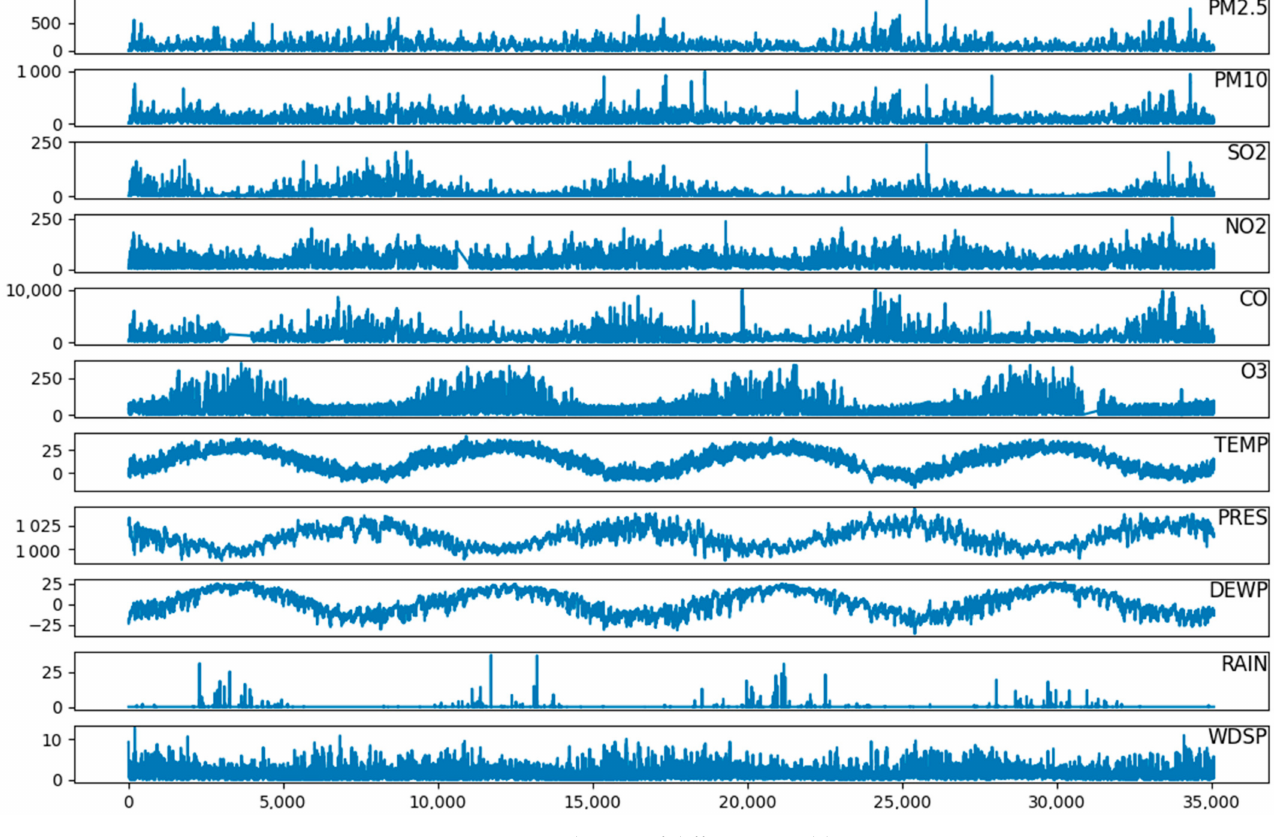
Figure 5. Distribution of different variables.